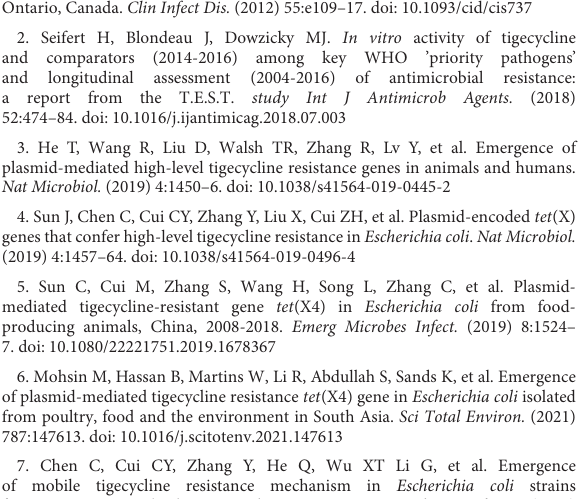
SUPPLEMENTARYFIGURE1 Structure analysis of bla NDM − 1 -bearing plasmid. Comparison analysis of the plasmid p19110F47-1 with other similar plasmids submitted in GenBank